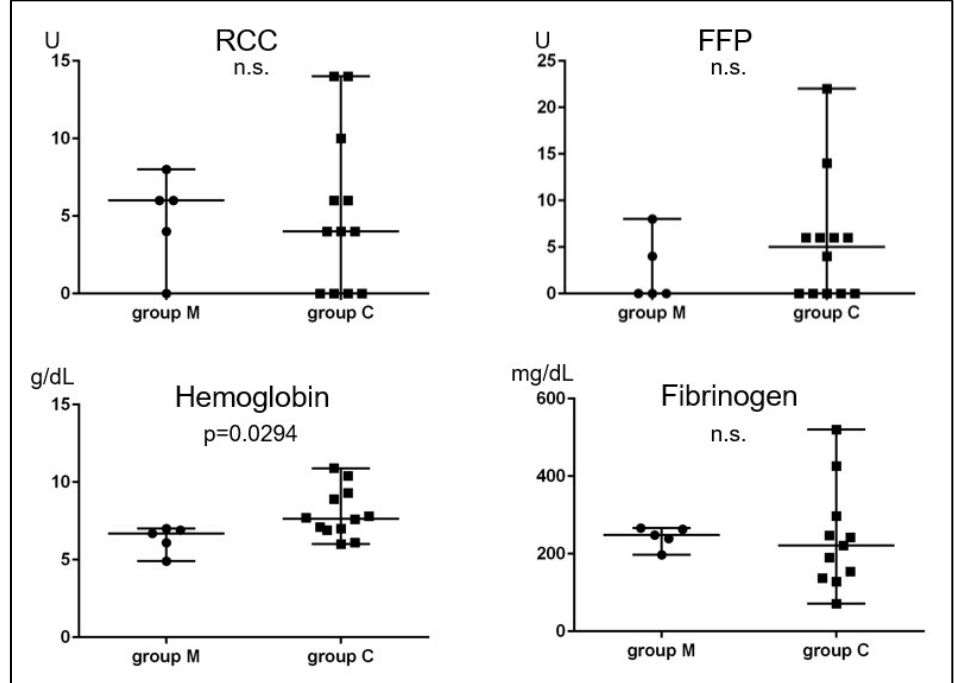
Figure 6. Univariate analysis between group M and group C at heavy bleeding. RCC: red cell concentrate; FFP: fresh frozen